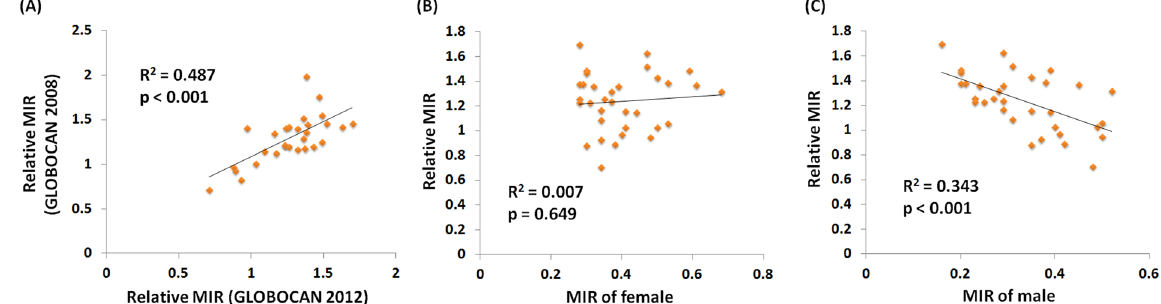
Figure 1. The scatterplots evidenced the relative MIR calculated using the GLOBOCAN 2012 database is positively related with that obtained using the GLOBOCAN 2008 database (n = 29) ( A ). The scatterplots correlate the relative MIR with ( B ) female MIR and ( C ) male